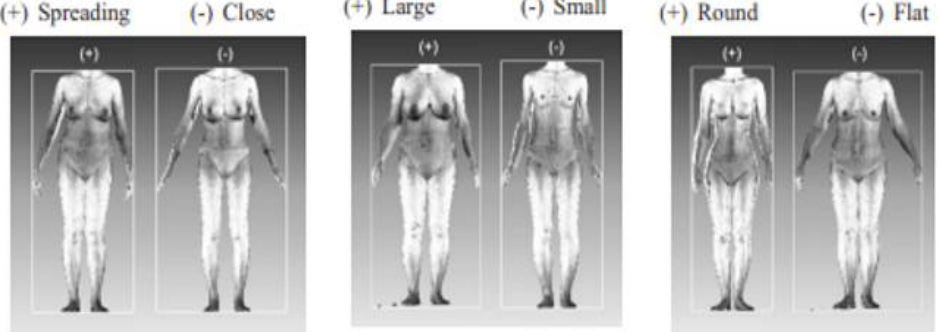
Figure 1. 3D scanning images showing differences in breast shape, size, and nipple position (repro- duced from [28] with permission from Elsevier).